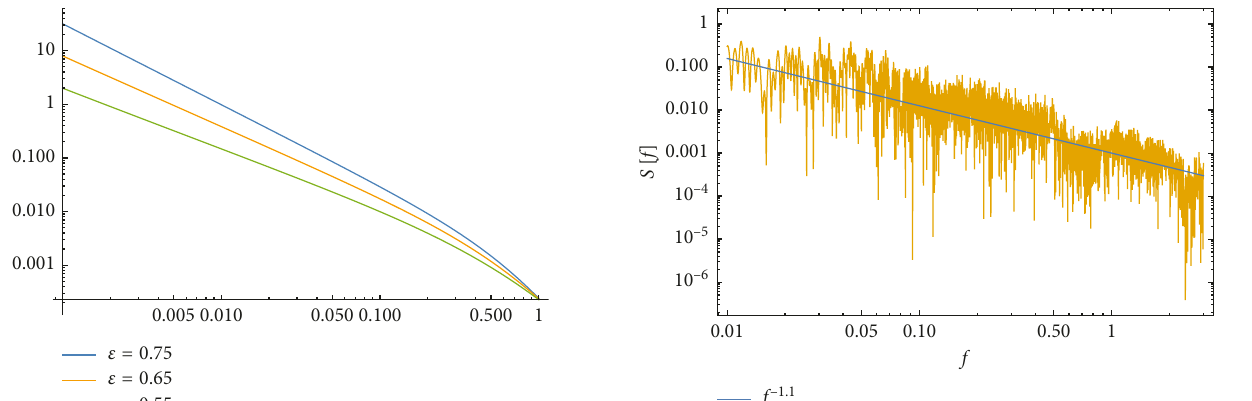
Figure 1: Log-log plot of the distribution (15) for I three different ε � 0 . 55 , 0 . 65 , 0 .